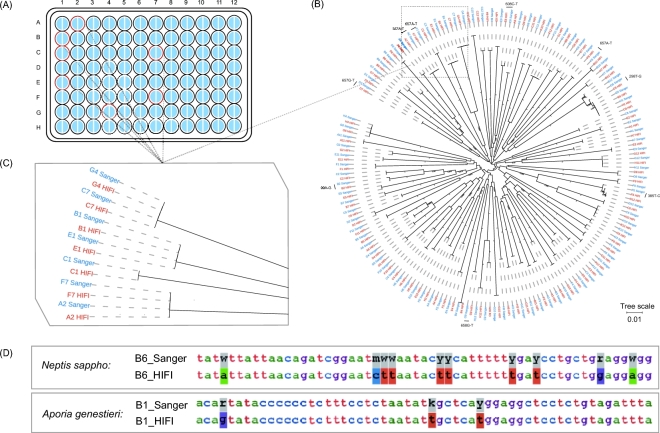
Comparison between HIFI-Barcode and Sanger reference. (A) Success rates of the first plate. For all 96 samples, both Sanger (left semicircle) and HIFI-Barcode (right semicircle) were successful in producing a full-length COI barcode. Samples with red out lining are marked on the phylograms. (B) Phylogenetic tree of all HIFI-Barcodes and Sanger references. (C) Close-up view of representative individuals. (D) Degenerate sites of Sanger references were recuperated by HIFI-Barcodes.